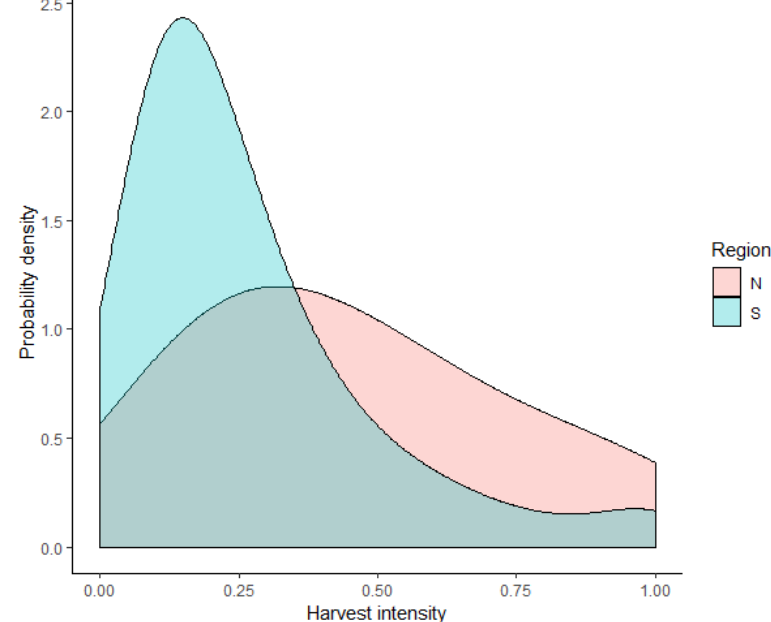
Figure 4. The distribution of harvest intensities for each of the regions (N = Northern Vermont and Northern New Hampshire from the FIA state data, S = all other area in the Connecticut River Watershed states) for one of the 10 replicates. Other replicates had similar distributions.